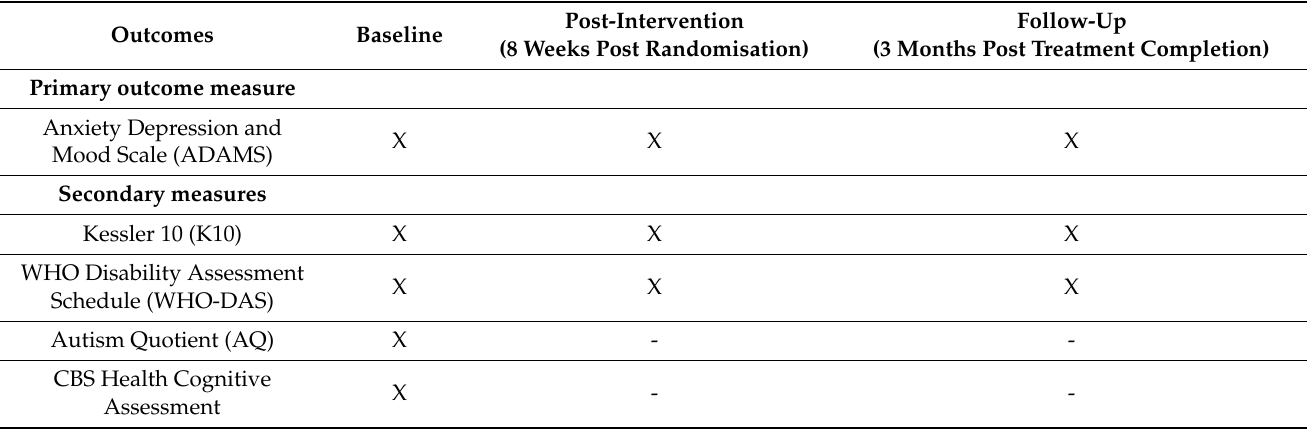
Table 1. Outcome measures completed at each measurement